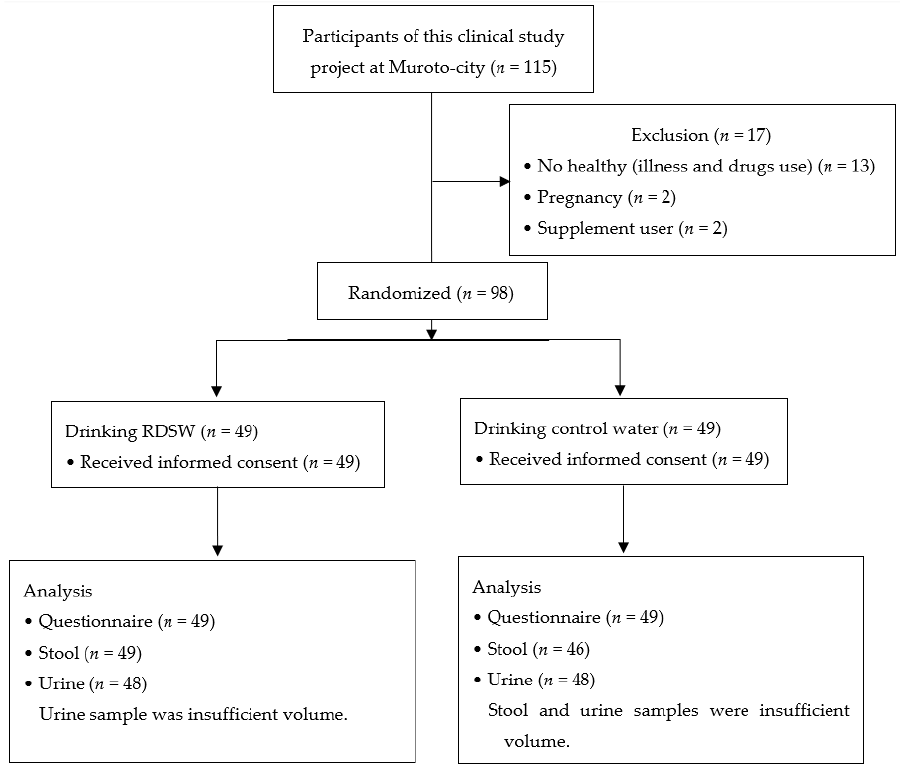
Figure 1. A total 98 healthy adults were enrolled from 115 adults who participated in this clinical study (industry–academia–government collaboration project) held in Muroto-city, Kochi, Japan. The subjects were healthy adults without any illnesses, and no prescription and commercial drugs use. Pregnant persons and supplement users were excluded from this study. RDSW, refined deep-sea